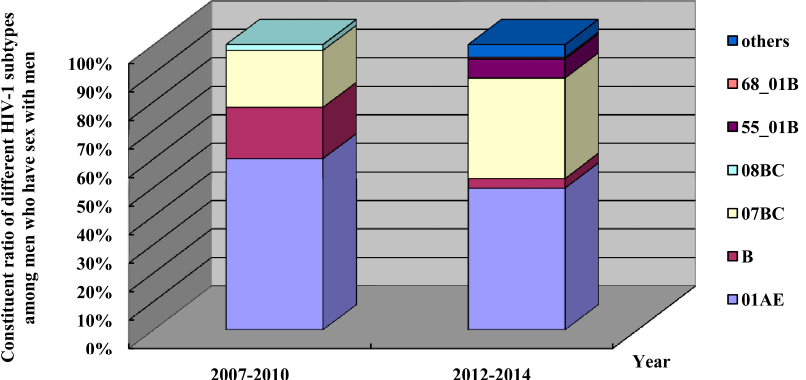
Figure 11. Distribution and shift of HIV-1 subtypes among men who have sex with men in Fujian Province, revealed by four molecular epidemiological surveys of HIV.